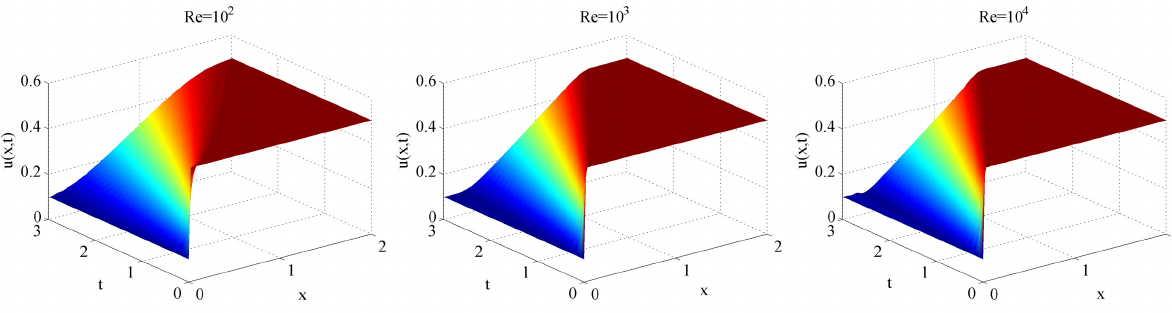
Figure 1. Dynamics of shock wave phenomena as the exact solution of viscous Burgers equation model at Re = 10 2 , Re = 10 3 , and Re = 10 4 ,